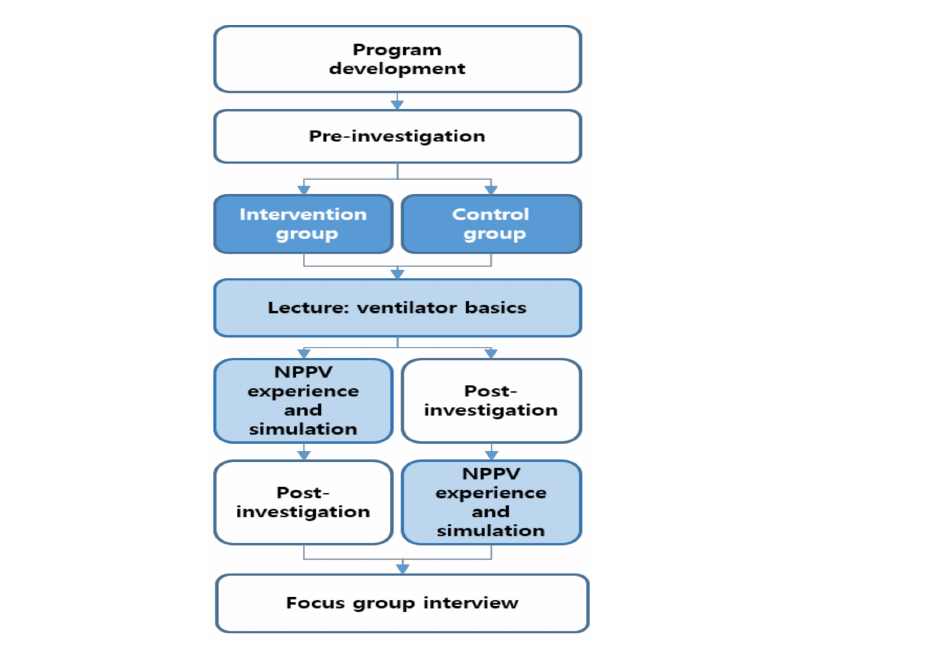
Figure 1. Study procedure. NPPV: non-invasive positive pressure